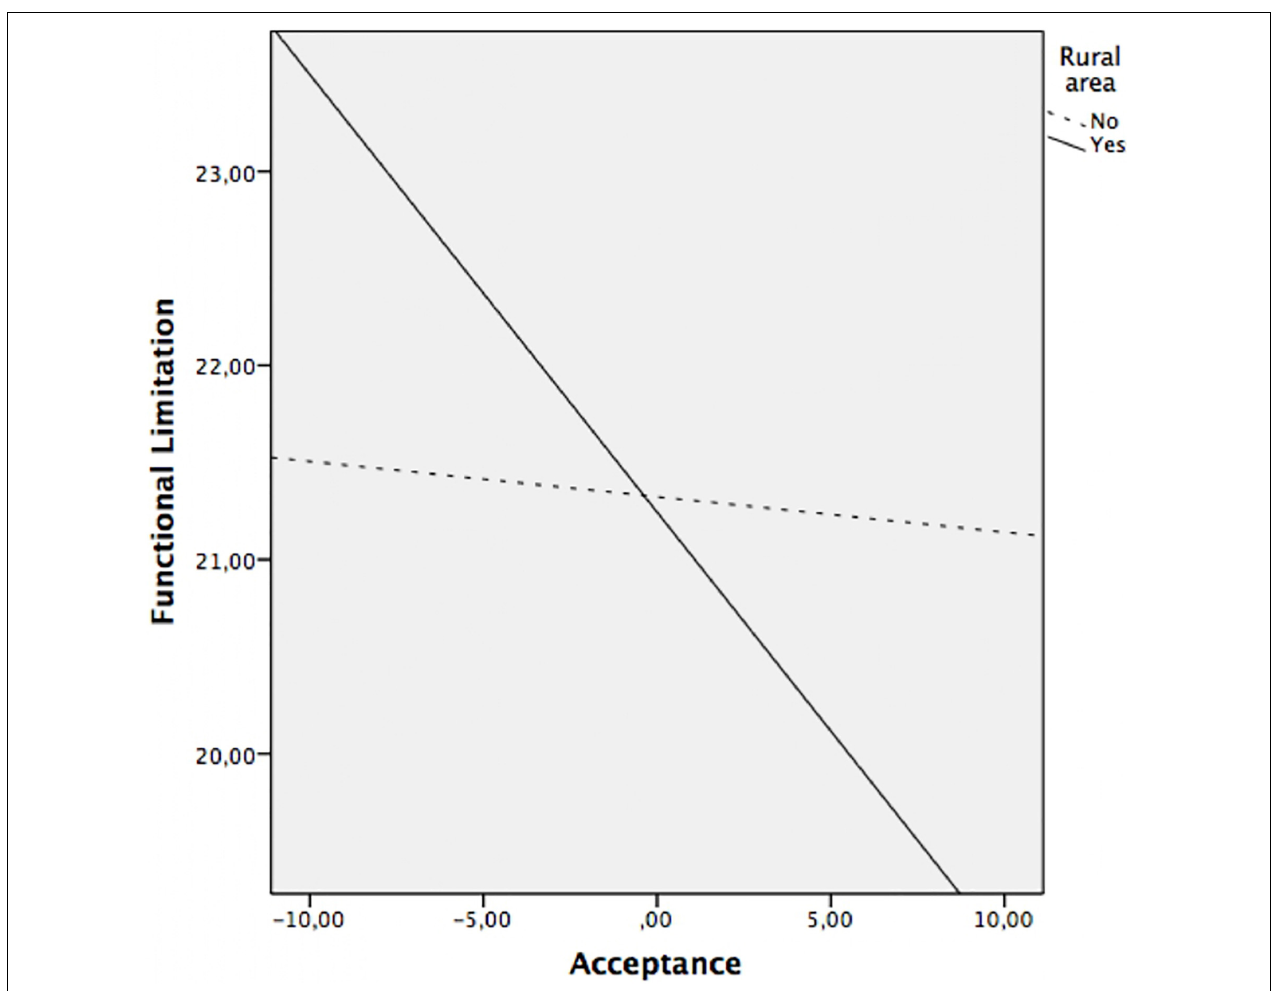
FIGURE 2 | Relationship between acceptance and functional limitation at rural area